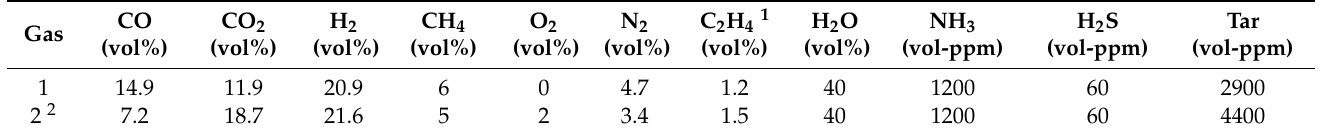
Figure 12. Plug flow reactor used in the carbon formation studies. Table 2. Gas composition for the carbon formation experiments. Gas1 [66] and Gas2 [5,67] refer to two different types of biomass gasification gas compositions used in this study.